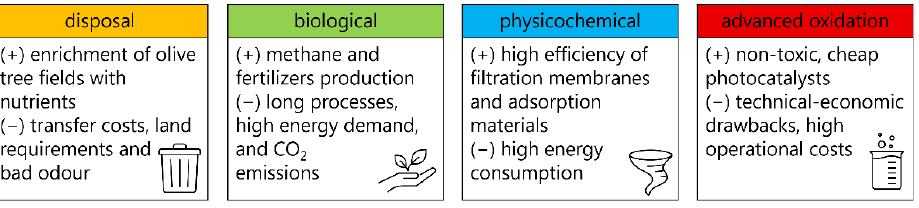
Figure 4. Main advantages/disadvantages of the standard technologies used for OMWW